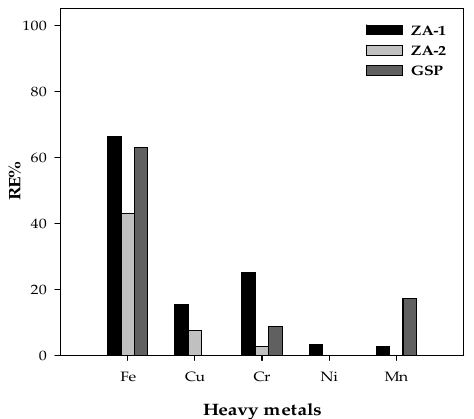
Figure 2. The removal percentages of heavy metals from water at an extremely acidic medium for samples ZA ‐ 1, ZA ‐ 2, and Greensand Plus (GSP).